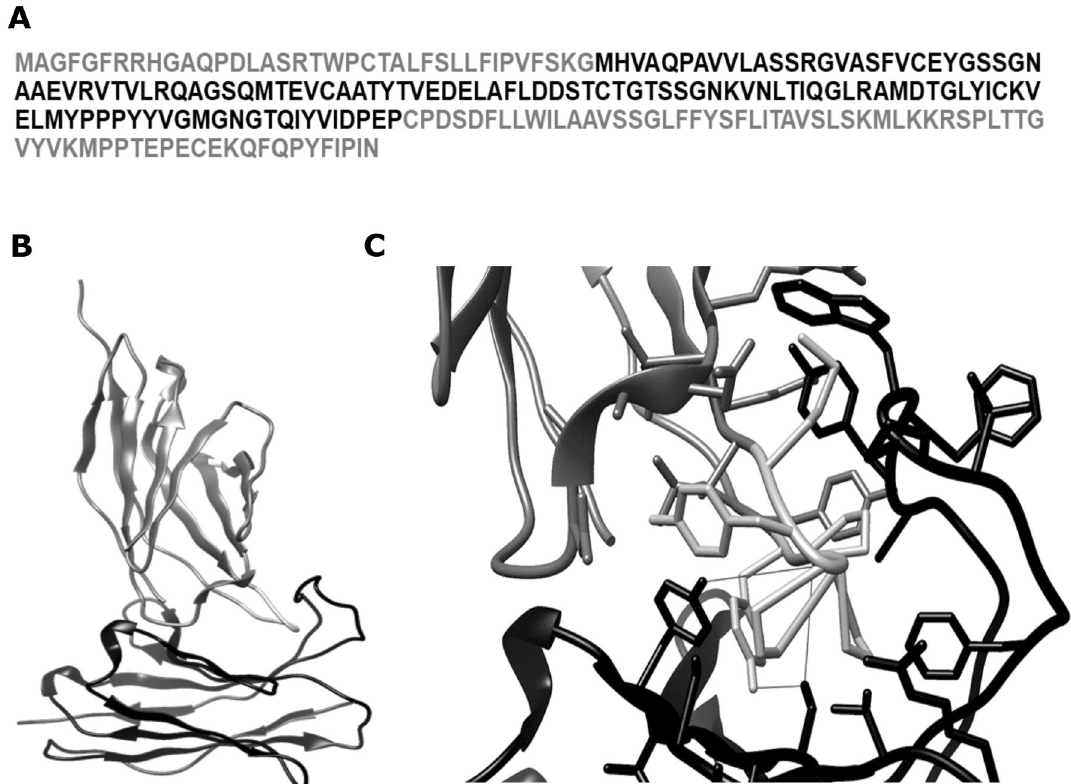
Figure 2. Anti-CTLA4 nanobodies binding to the MYPPPY epitope of canine CTLA4. ( A ) The FASTA sequence of canine CTLA4, where the conserved modeled domain has been highlighted in black and the rest in light gray. ( B ) A globally docked complex of anti-CTLA4 nanobody cNb6 (black) and canine CTLA4 (dim gray) with the MYPPPY epitope (dark gray) interacting with the nanobody CDRs. ( C ) A detailed view of the interacting molecules in ( B ) with intermolecular hydrogen bonds (fine gray straight lines) between Ser-Pro/ Ser-Tyr/Tyr-Pro residues near the center of the image. Additionally, there are several intermolecular aromatic residue interactions around the target epitope, which represents hydrophobic